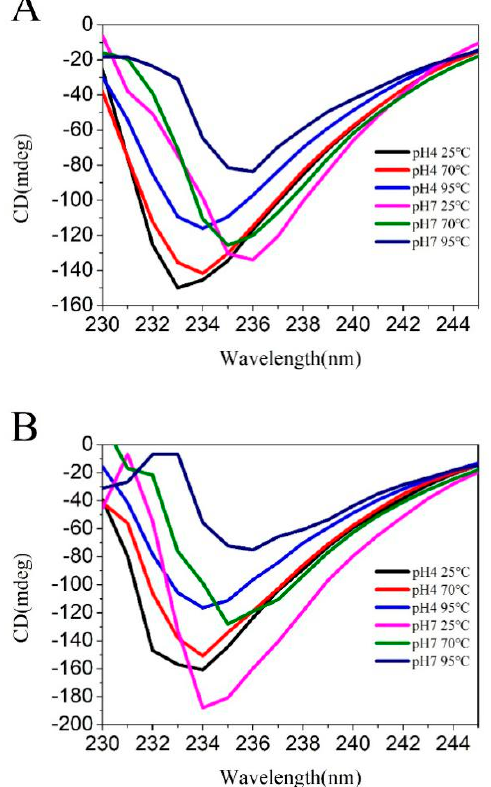
Figure 6. Far-UV CD spectra of LF NPs ( A ) and LF-CA NPs ( B ).